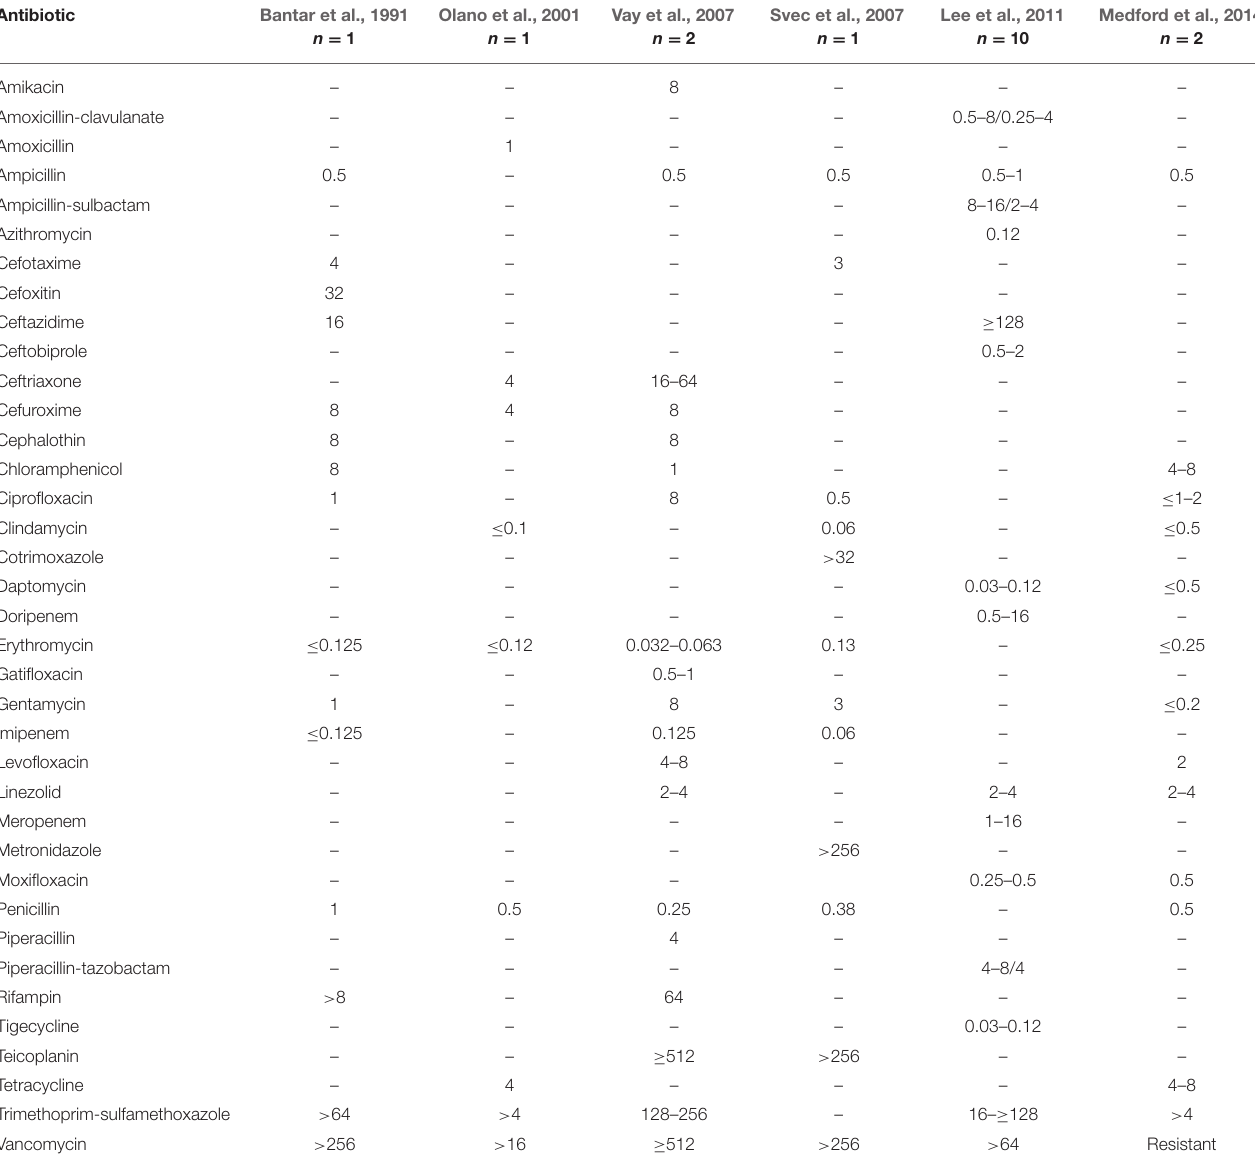
TABLE 2 | Minimum Inhibitory Concentrations (MICs, in µ g/mL) of Weissella confusa to various antibiotics.